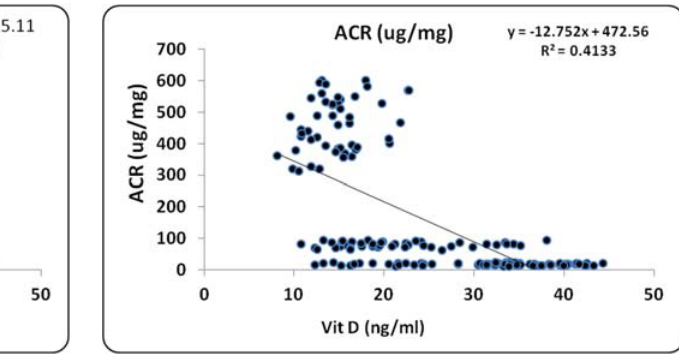
Figure 4: Scatter plot with regression line between vitamin D and IL - 6.